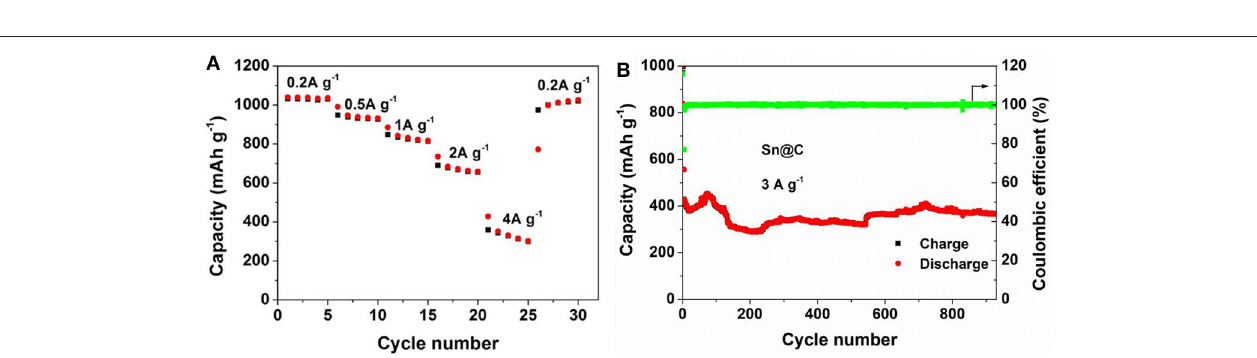
FIGURE 5 | (a) SEM and (b) TEM of Sn@C after 40 cycles at 0.8A g − 1 , (c) SEM, and (d) TEM of Sn@C after 500 cycles at 0.8A g − 1 .